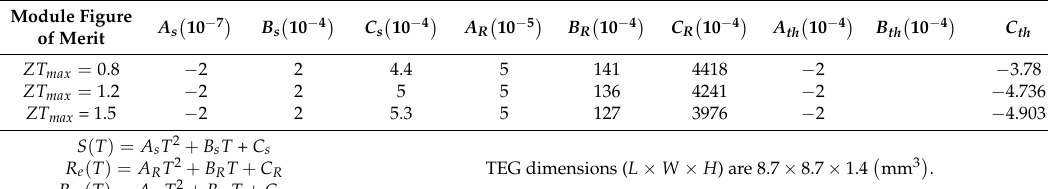
Table 2. TEG temperature dependent properties in one verified (ZT = 0.8) and two (Z = 1.2 and ZT = 1.5) modified conditions.